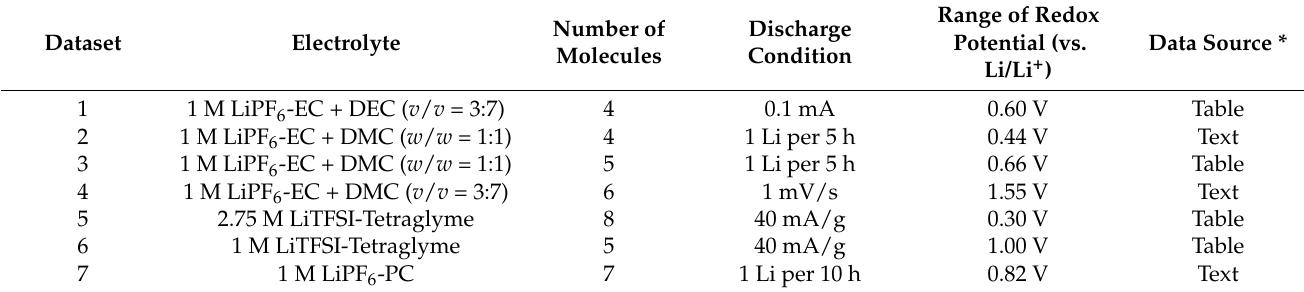
Table 1. A summary of experimental data for each of the seven calibration datasets.